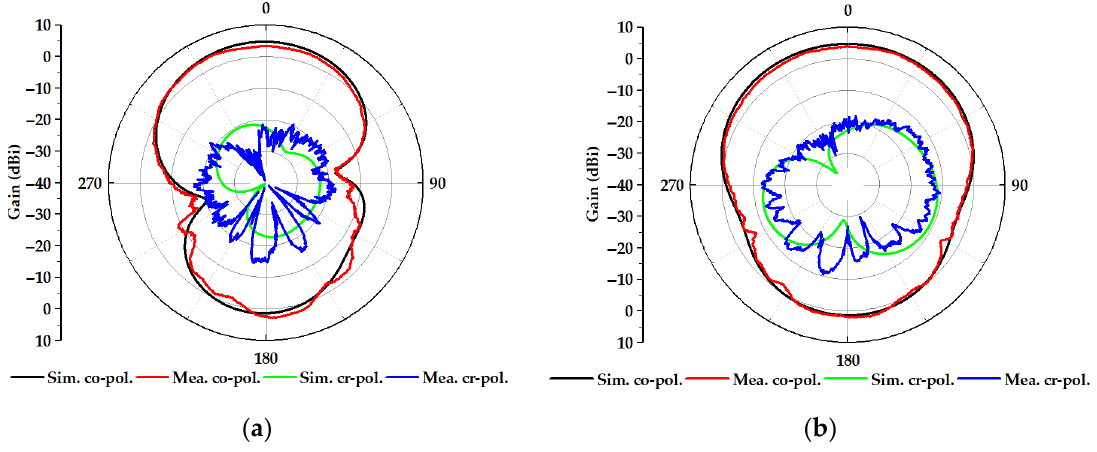
Figure 6. ( a ) Simulated and measured E ‐ plane far ‐ field patterns of the miniaturized spoof plasmonic dipole antenna ( n = 5). ( b ) Simulated and measured H ‐ plane far ‐ field patterns of the miniaturized spoof plasmonic dipole antenna ( n = 5).